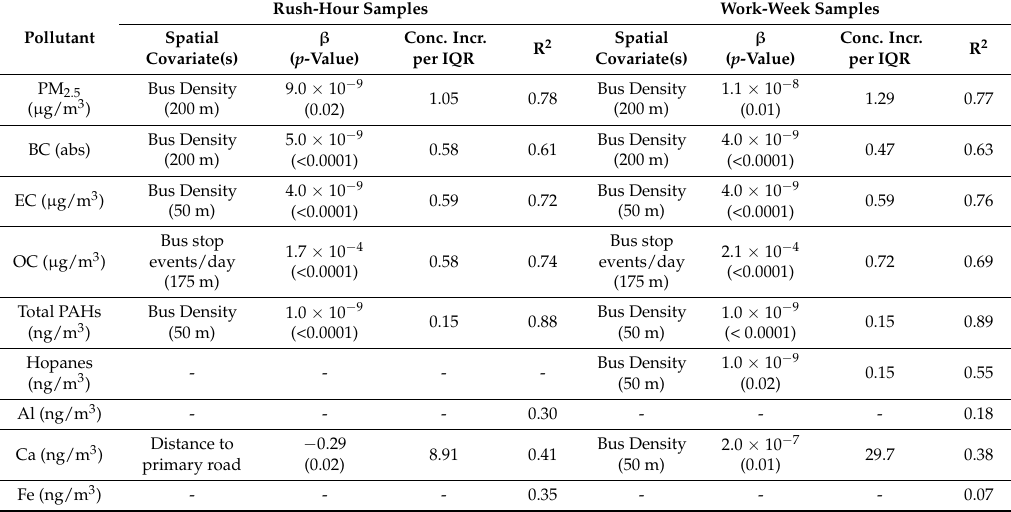
Table 3. Winter rush-hour and work-week LUR summary for all modeled pollutants. All models include a temporal term (mean reference site concentration for the session).